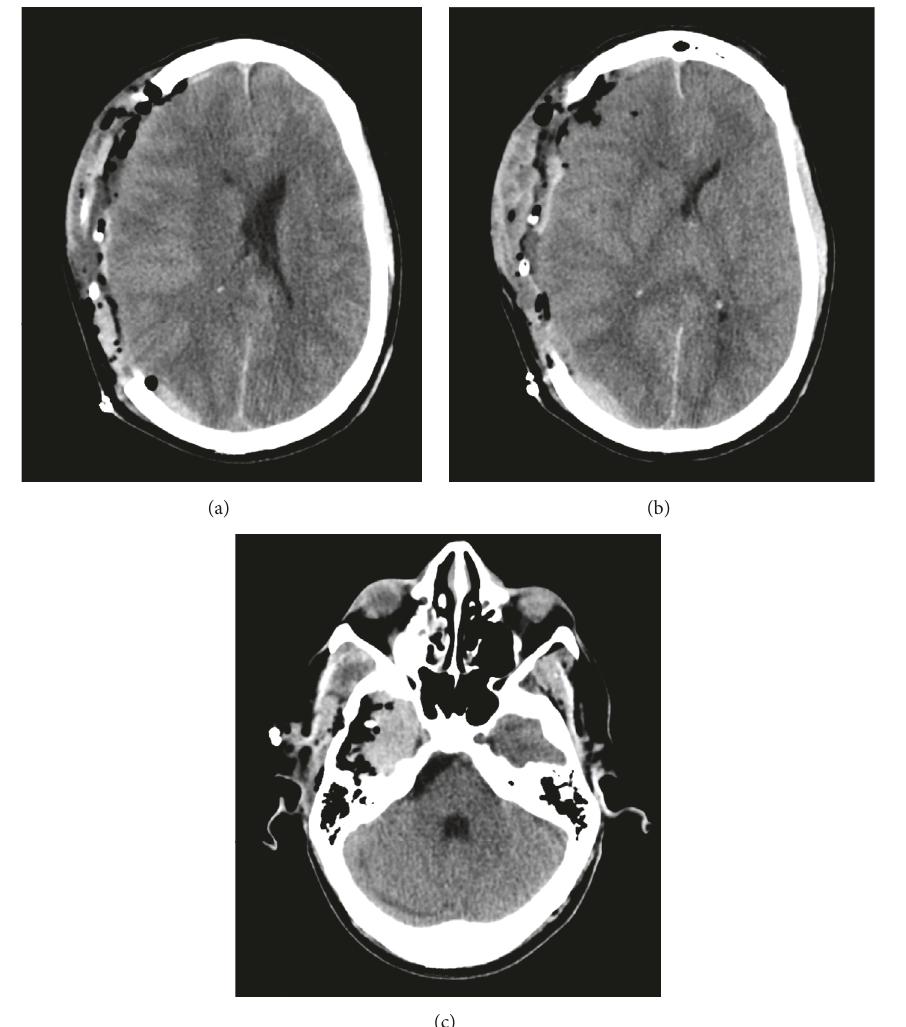
Figure 3: Immediate postoperative head CT showing complete resection of subdural hyperdensity (a) with loss of midline shift seen previously (b) and small subtemporal hematoma